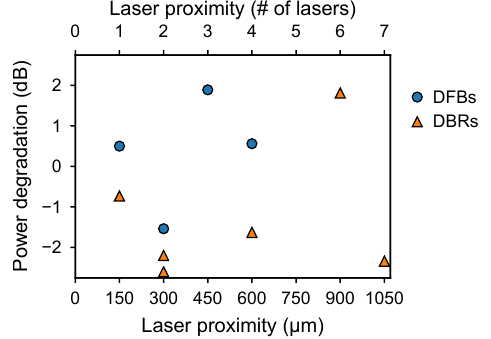
Figure 12. Power degradation dependence on proximity for multiple pairs of